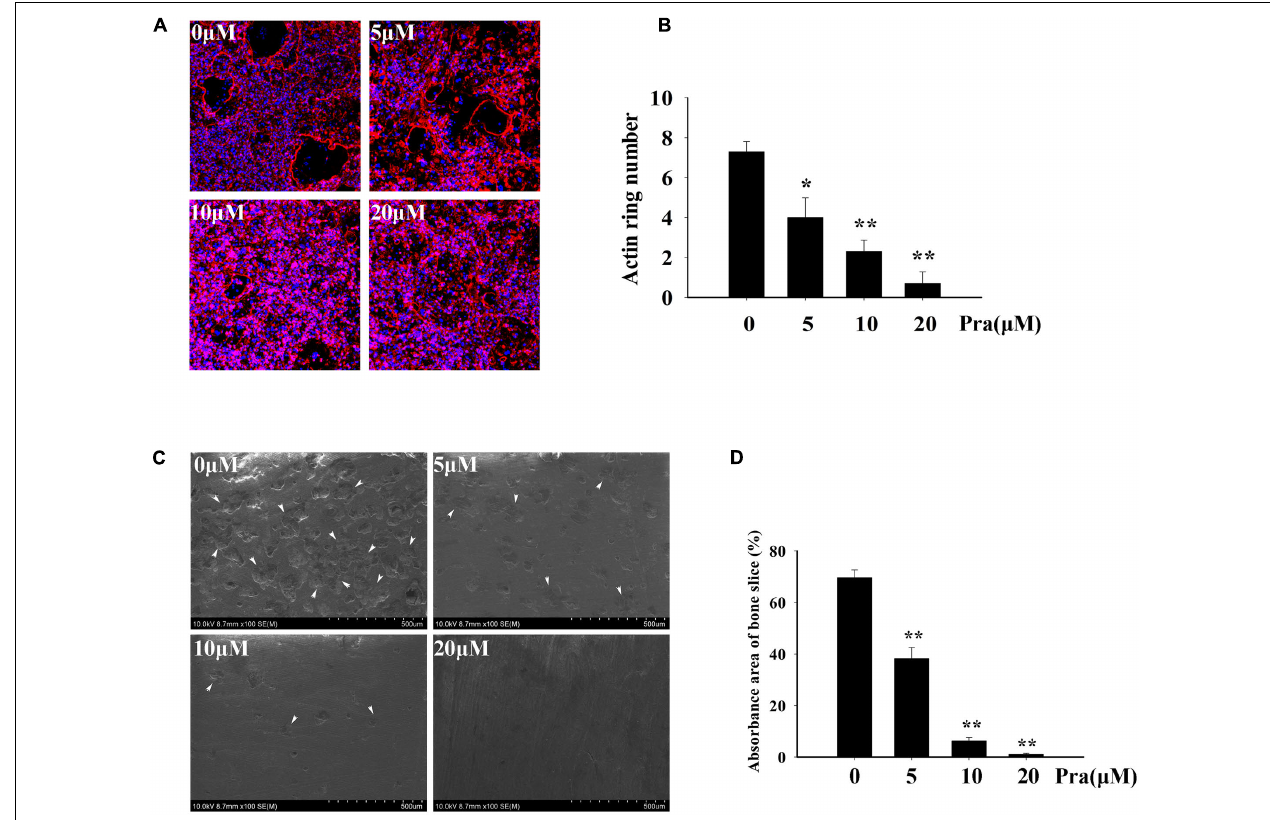
FIGURE 3 | Pra-C impairs F-actin ring formation and inhibits osteoclast bone resorption function. (A) BMM-derived osteoclasts were cultured on bovine bone slices and treated with M-CSF (30 ng/mL), RANKL (50 ng/mL), and the indicated concentrations of Pra-C (0, 5, 10, or 20 µ M) for another 48 h. Cells were then fixed and stained for F-actin ring formation with Alexa-Fluor 647 phalloidin (red) and imaged on a NIKON confocal system. Representative images are shown. Characteristic F-actin rings were formed in untreated groups. When treated with Pra-C, the formation was suppressed in a concentration-dependent manner. (B) Quantification of F-actin ring count using Image J software. (C) BMM-derived osteoclasts were cultured on bovine bone slices to conduct a pit resorption assay. Representative SEM images are shown. When subjected to an SEM scanning of bone slices, vast resorption pits were observed in the control group, but they were significantly decreased after treatment with Pra-C. The inhibitory effect occurred in a concentration-dependant manner. The white arrowheads represent resorption pits on bone slices. (D) The percentage of absorbance area of bone slices was quantified using Image J software and plotted. All experiments were performed at least three times. All plotted data are the means ± SD. Significant differences were determined using SNKq test. ∗ P < 0.05; ∗∗ P < 0.01, versus 0 µ M